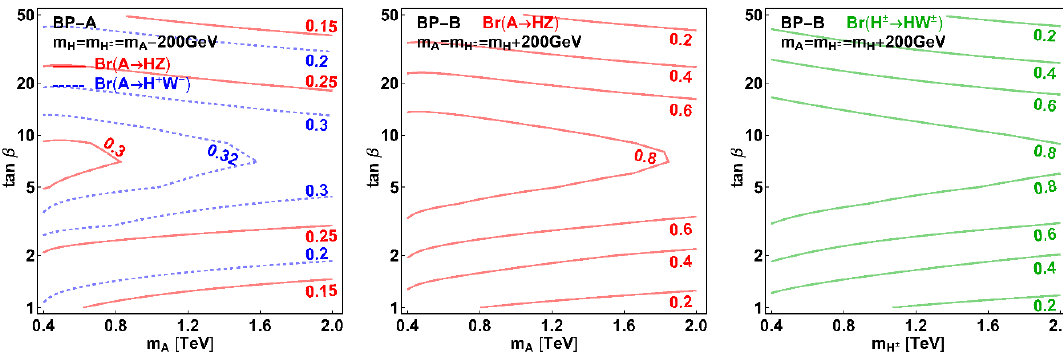
Figure 3 . Branching fractions for the exotic Higgs decays A ! HZ (red), A ! H + W (cid:0) (blue) and H (cid:6) ! HW (cid:6) (green). Here we consider the benchmark points BP-A (left) and BP-B (center and right) with a mass splitting between the heavy Higgs bosons of (cid:1) m = 200